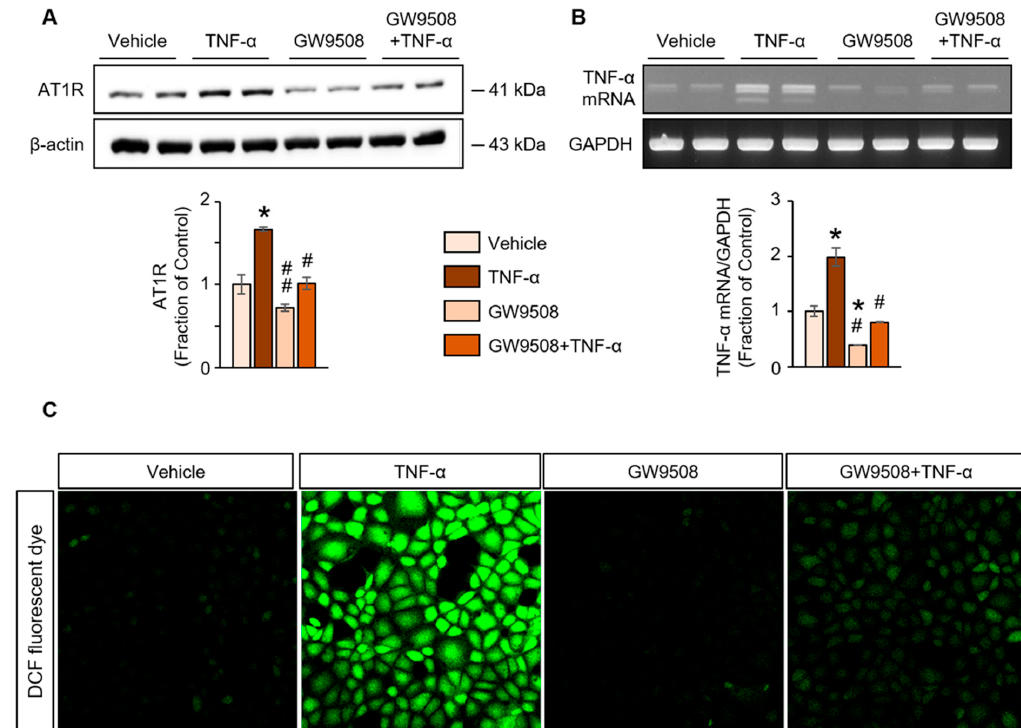
Figure 5. ( A ) Western blot analysis of angiotensin II type 1 receptor (AT1R) protein, ( B )